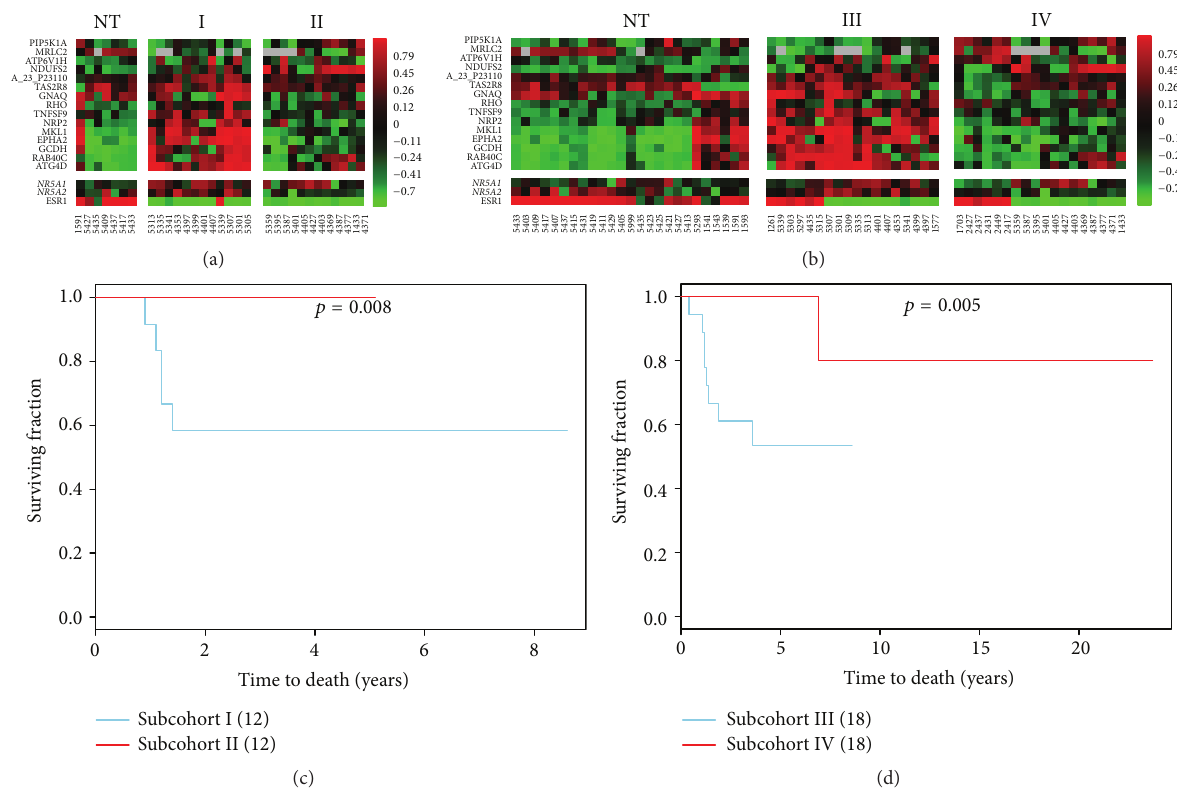
Figure 5: Validation of a prognostic signature conditioning poor outcomes in subsets of ER( − ) IDCs and 181 IDCs. Poor clinical outcome in a subset of ER( − ) IDCs and a subset of 181 IDCs is determined by 15 probes that are predicted to be regulated by a transcription factor, NR5A2 . Panel (a, b) presents the heatmap displaying 15 prognostic relevant probes, which are predicted to show the consensus expression pattern in both the 91A and 181A cohorts. These 15 probes are part of the most relevant transcriptional activities of NR5A2 in a subset of ER( − ) IDCs (a) or in the subset of 181 IDCs predominantly containing ER( − ) subtype (b). Panel (c, d) demonstrates significant differences in clinical outcomes based on Kaplan-Meier survival curves when comparing subcohorts I (12A)/II (12A) (c) and subcohorts III (18A)/IV (18A) (d). “NT” stands for nontumor